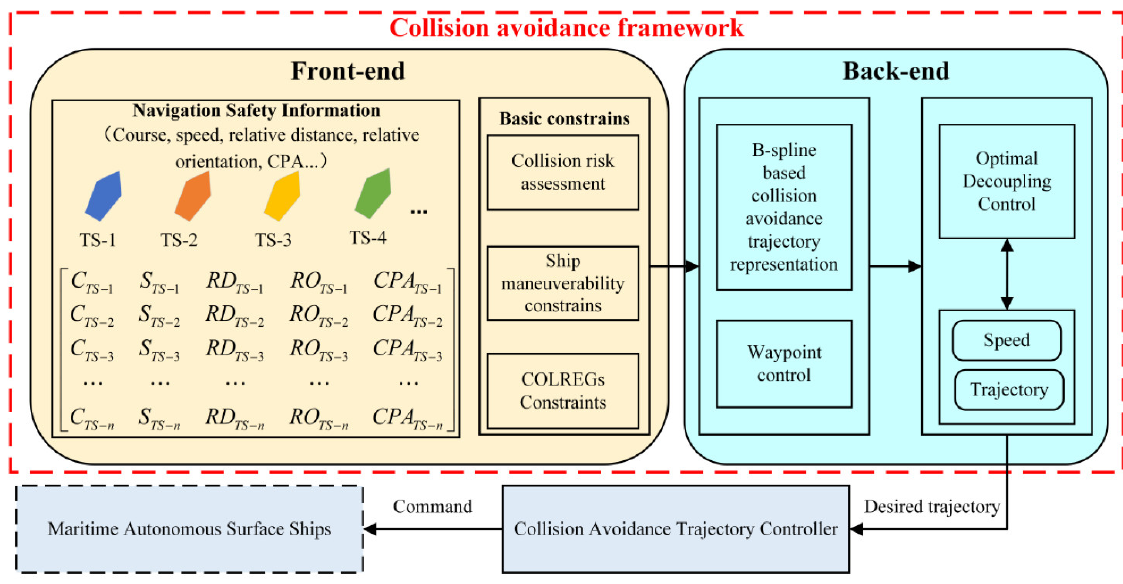
Figure 1. The framework of autonomous navigation system for MASS, collision avoidance included. In Figure 1, C is the course, S is the speed, RD is the relative distance from the own ship to the target ship, RO is the relative orientation between the own ship and the target ship, CPA is the closest point of approach between the own ship and the target ship, TS − n is the n th target ship, and n is a positive integer, and